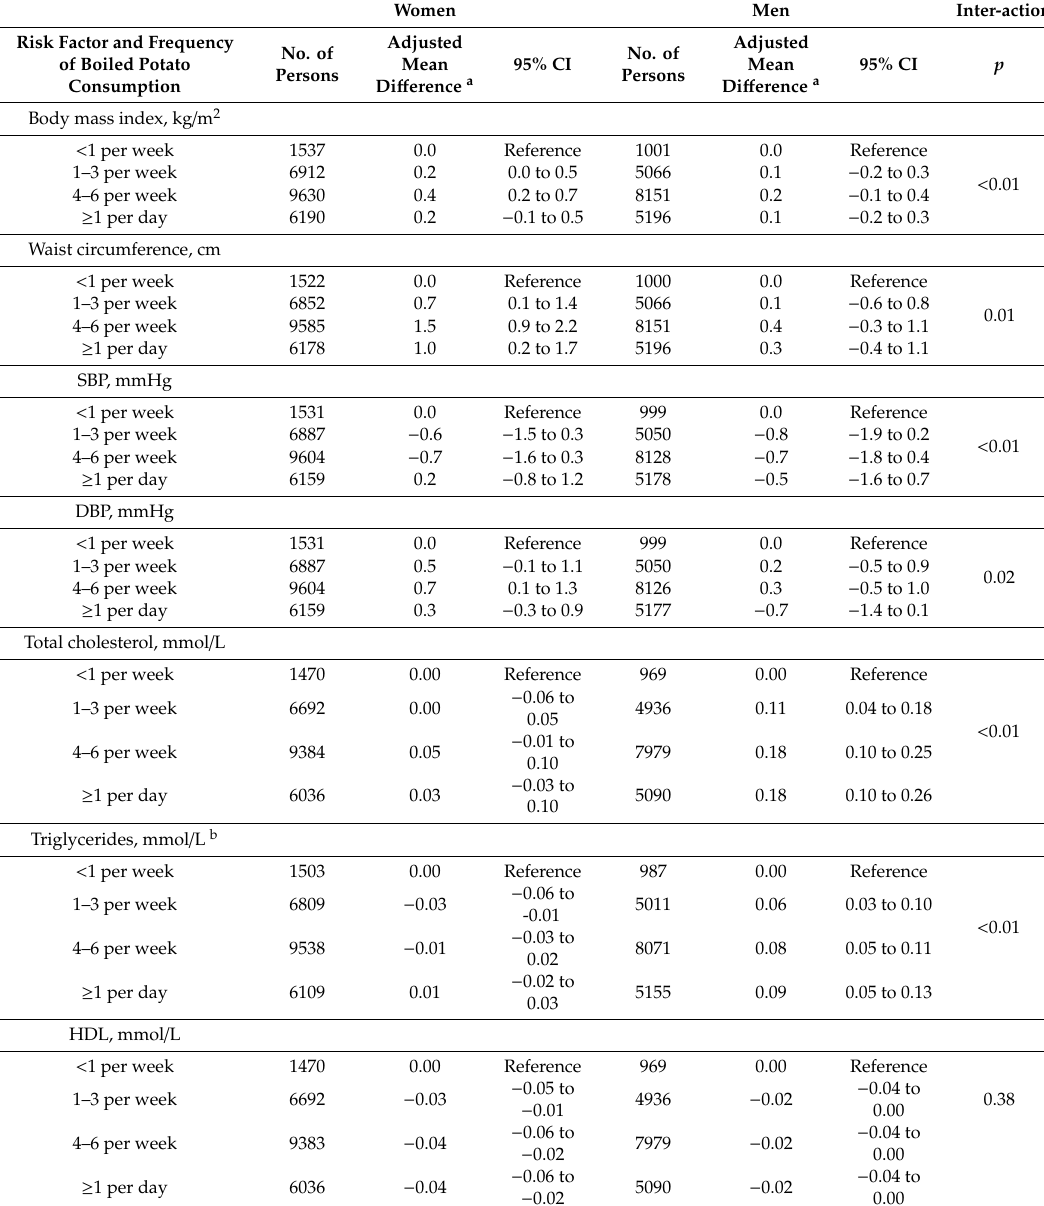
Table 3. Mean di ff erence in cardiovascular disease risk factors according to potato consumption, stratified by